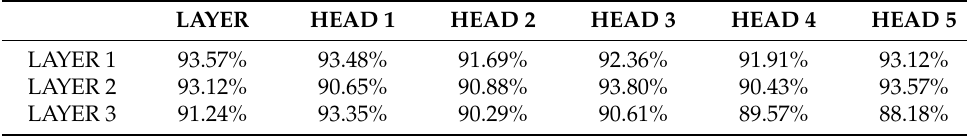
Table 4. Accuracies of each T-GEM layer/head output via